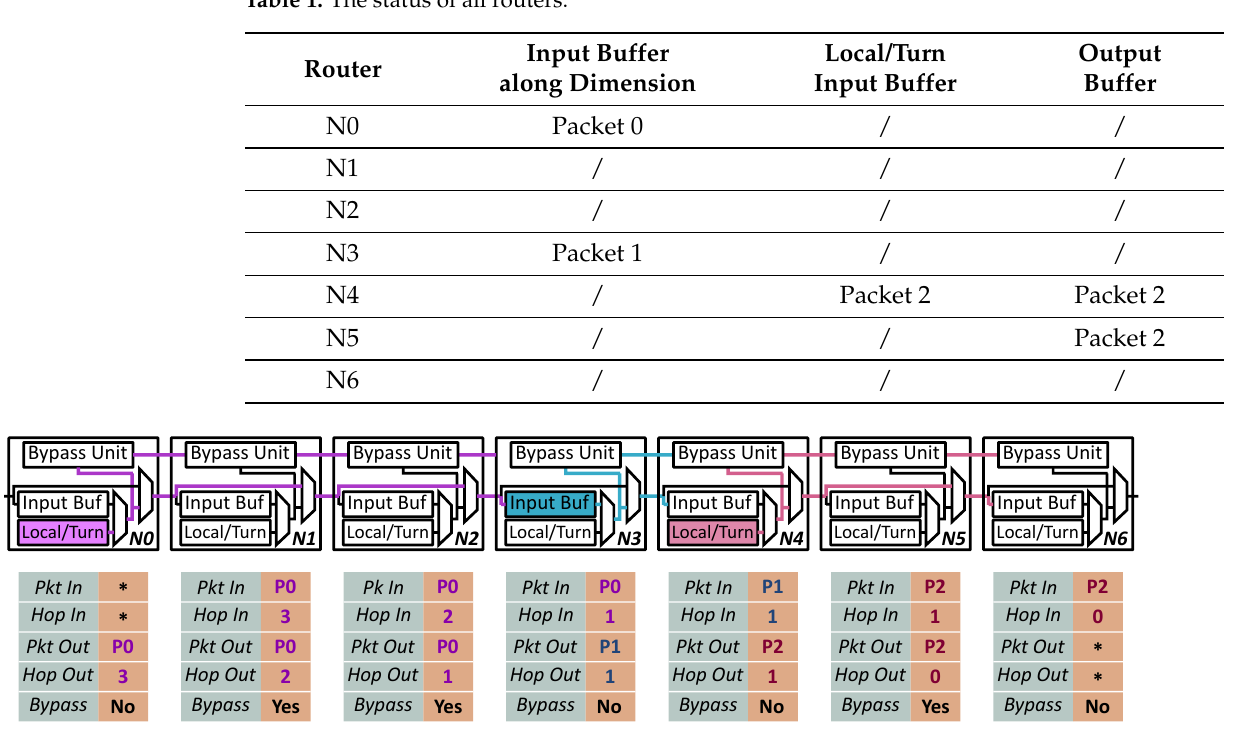
Figure 5. Transmission